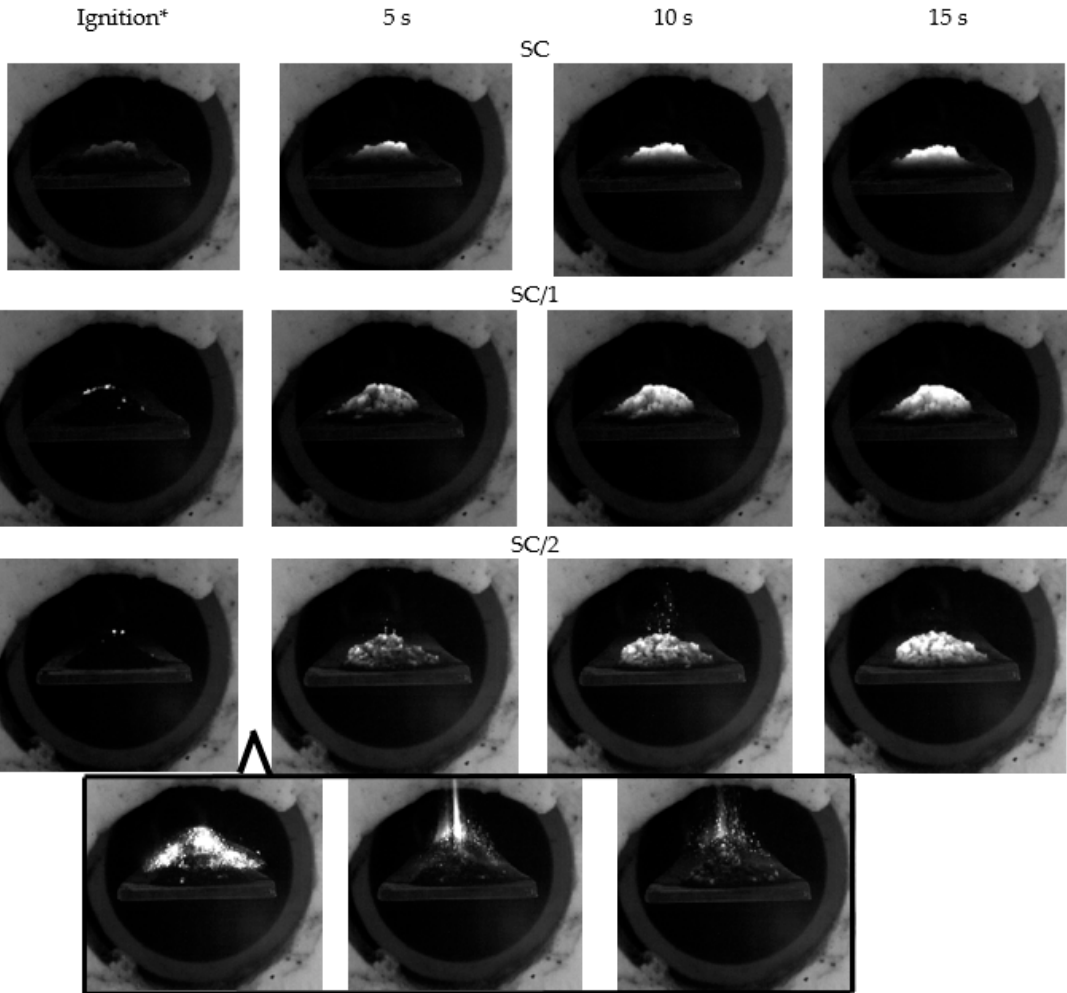
Figure 6. The ignition and subsequent combustion of SC series samples at a heating medium Figure6. TheignitionandsubsequentcombustionofSCseriessamplesataheatingmediumtemperature temperature of 800 °C. (* Ignition delay time: SC—1.7 s, SC/1—0.3 s, SC/2—0.2 s). of 800 ◦ C. (* Ignition delay time: SC—1.7 s, SC / 1—0.3 s, SC / 2—0.2